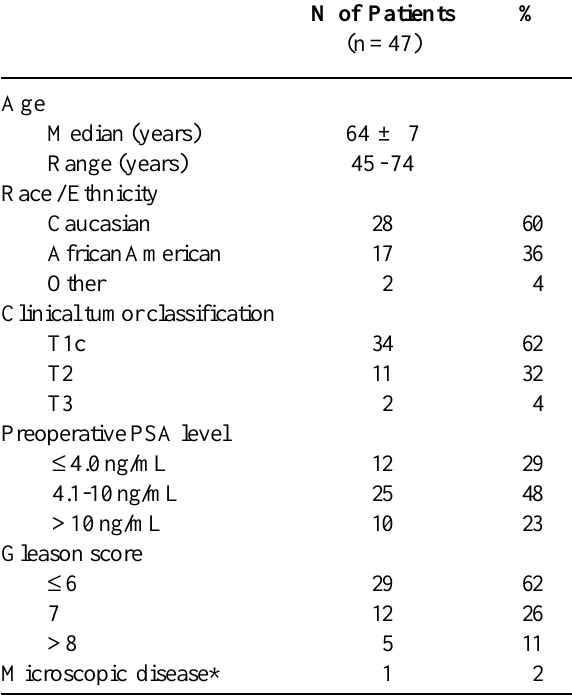
Table 1 – Clinicopathologic characteristics of study cohort.